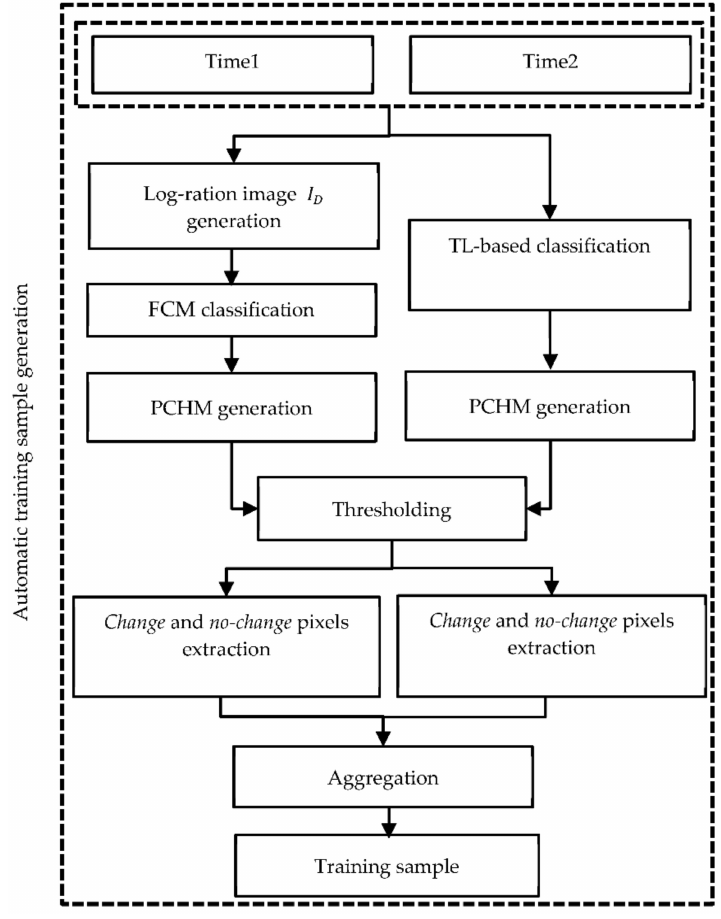
Figure 2. Flowchart of the proposed parallel pseudo-label training sample generation. FCM is fuzzy c-means, PCHM is probabilistic change map, and TL is transfer